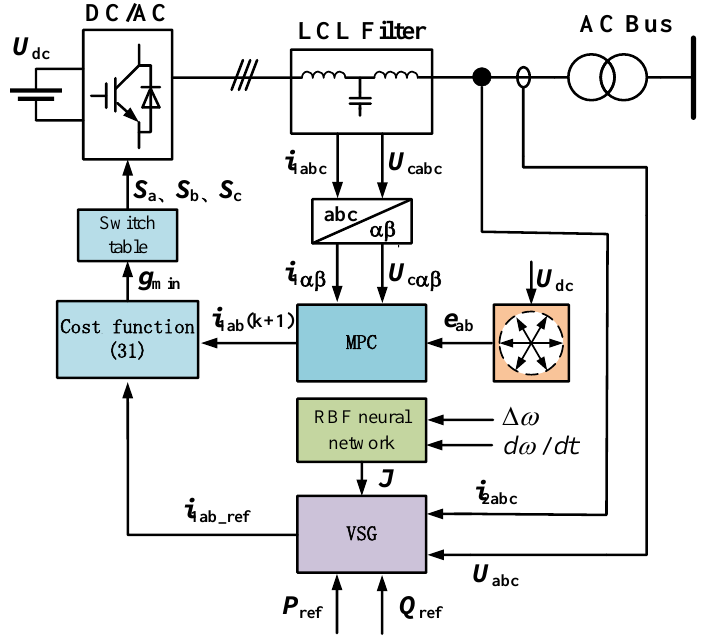
Figure 4. The control structure of proposed MPC-VSG-RBF.